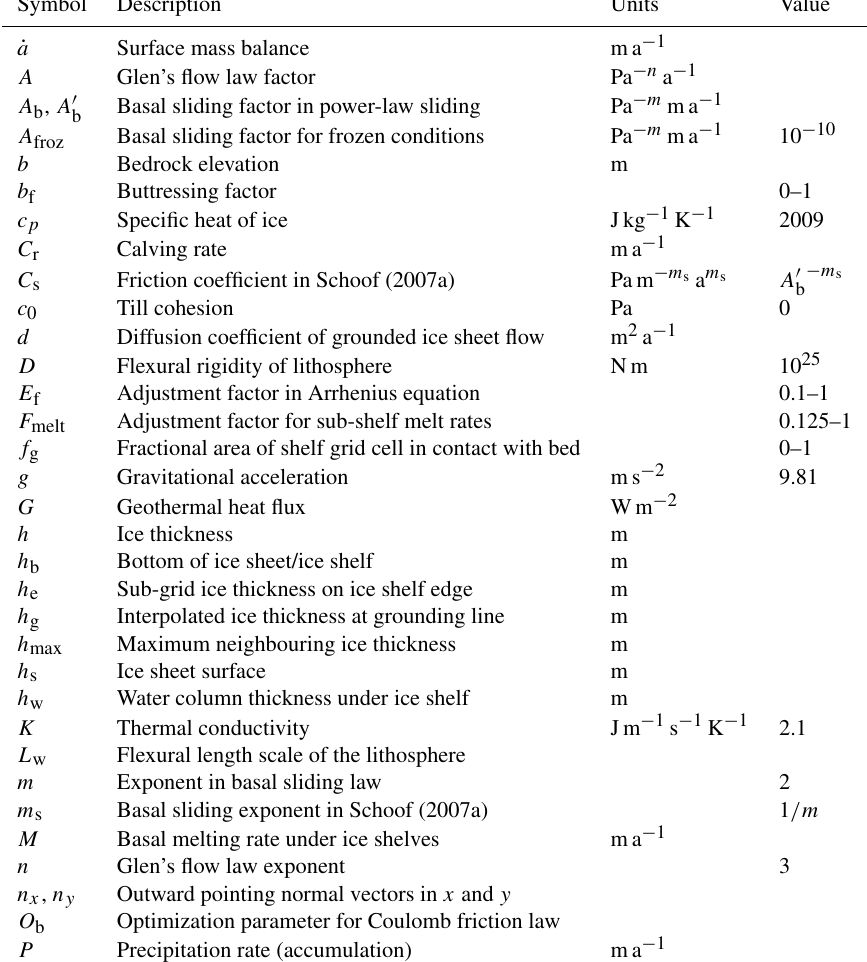
Table 1. Model symbols, units and nominal